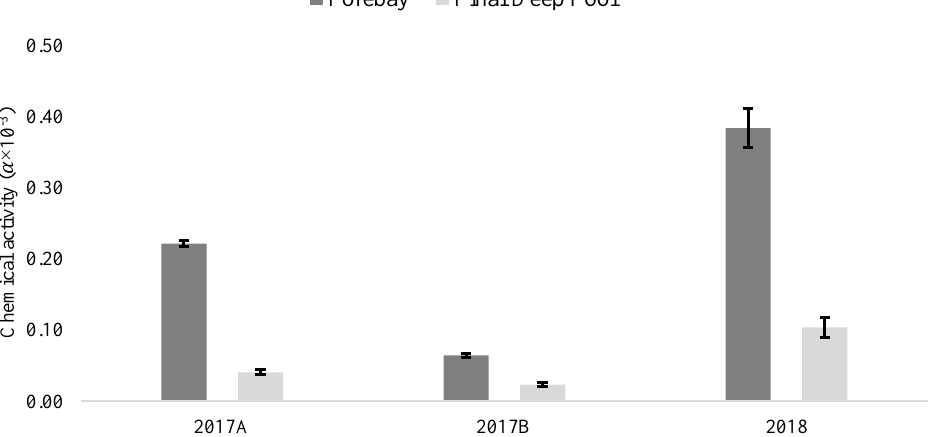
Figure 6. Total chemical activity of Σ PAHs in the polyethylene samplers in the forebay and final deep pool during each deployment.